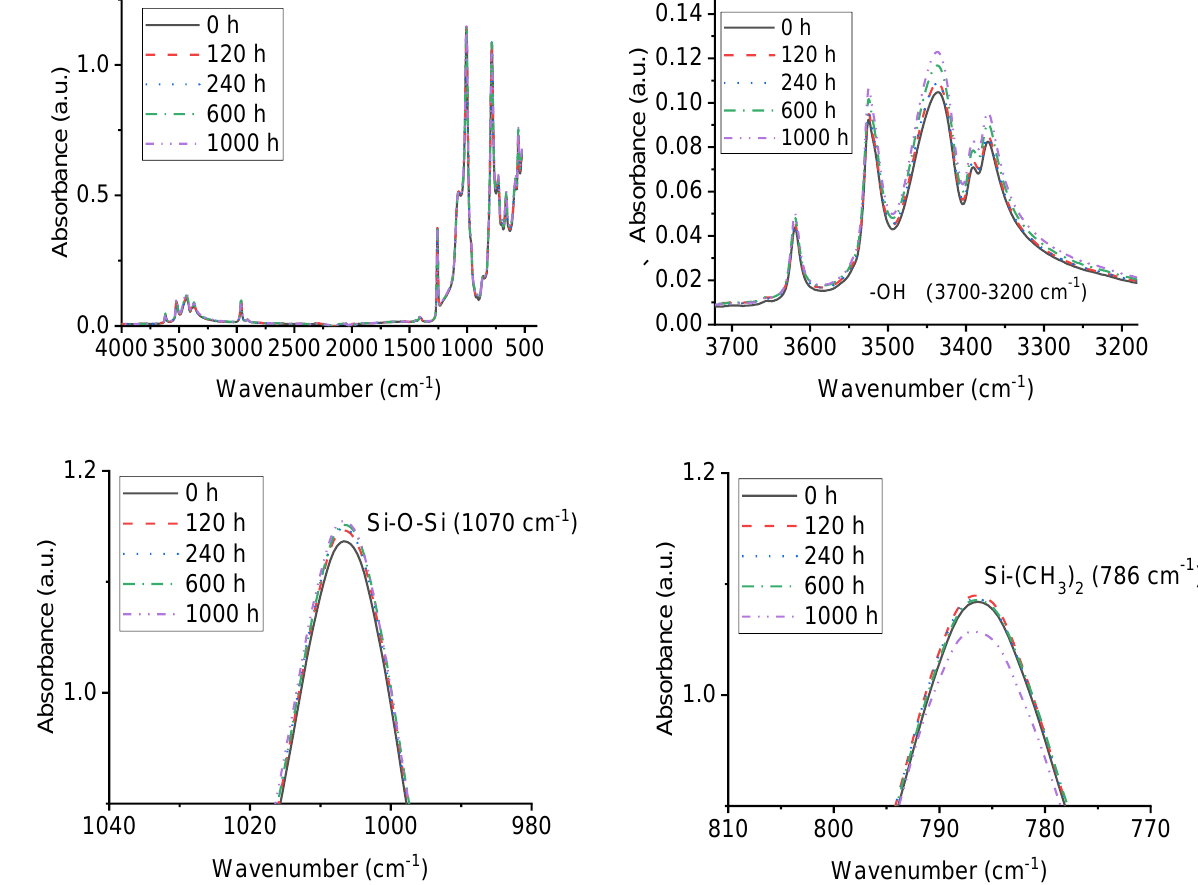
Figure 11. FTIR analysis of HTV silicone rubber at different UV-A aging times. Table 2. The wavenumbers corresponding to the main chemical bond in HTV silicone rubber.